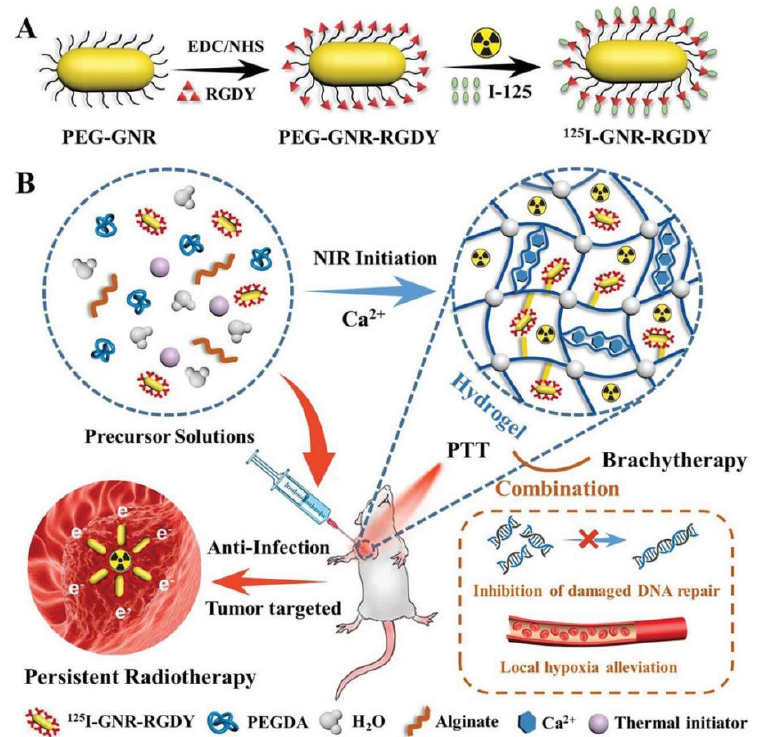
Figure 11. (A) Schematic illustration of the preparation of the modi fi ed gold nanorods and (B) the PEGDA-alginate double-network nanocomposite hydrogel and their application for combinational PTT-brachytherapy. Reprinted with permission from [247].